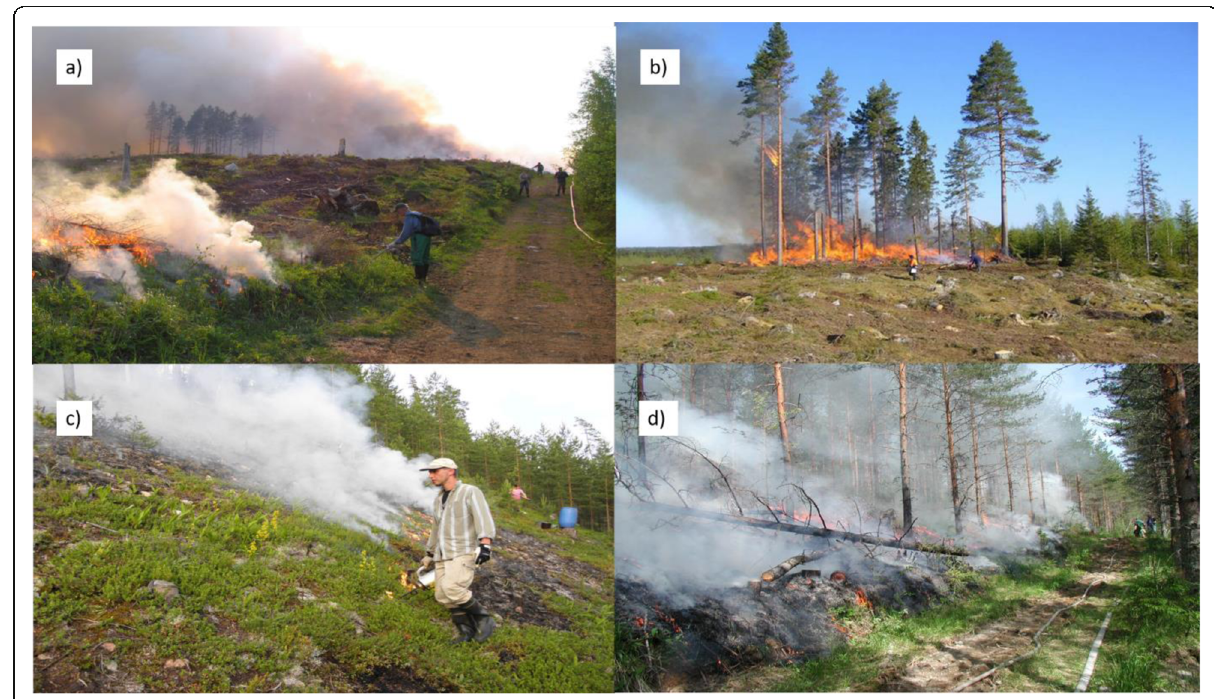
Fig. 4 Examples of different types of prescribed burning in Finland: a silvicultural prescribed burning with retention, b burning of a single retention-tree group, c habitat management burning of a sun-exposed esker slope, d restoration burning of a managed Scots pine stand in a conservation area. Photos: Henrik Lindberg ( a ), Juha-Matti Valonen ( b ), Timo Vesanto ( c ), Raimo Ikonen ( d